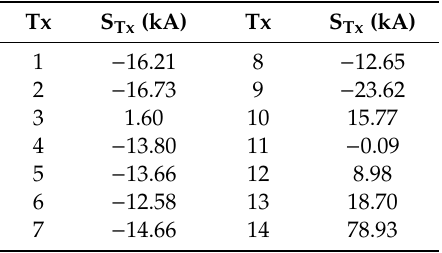
Table 10. Sum of deviation in short circuit current (SCC) for each